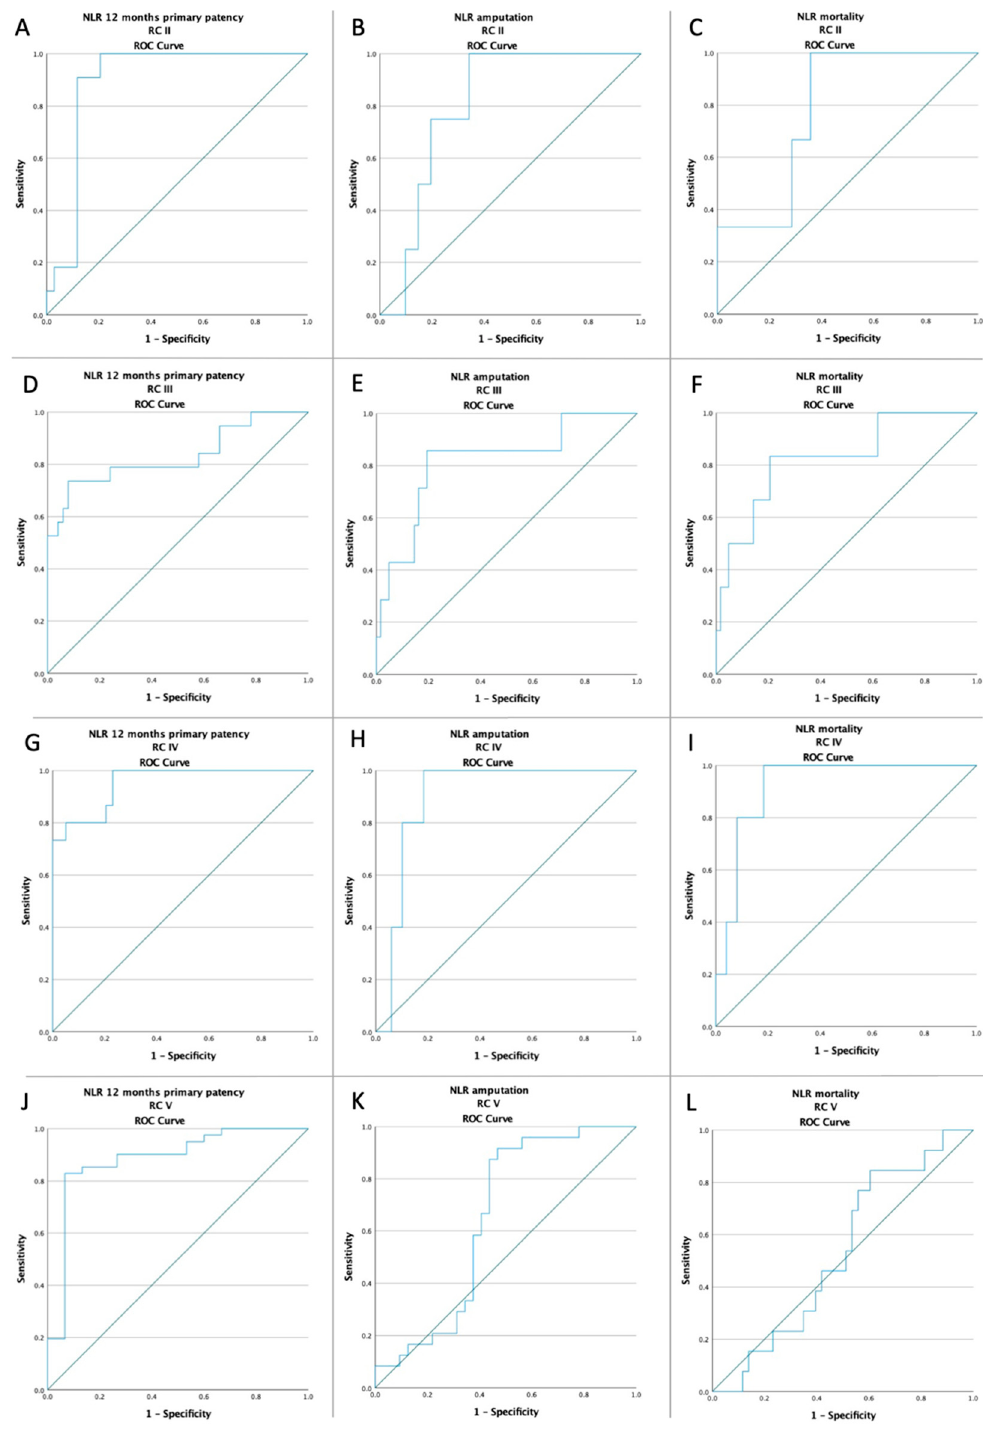
Figure 2. ROC curve analysis ( A ) for NLR with respect to 12 months primary patency in RC 2 patients (AUC: 0.893; p < 0.001), ( B ) for NLR with respect to amputation rate in RC 2 patients (AUC: 0.805; p = 0.046), ( C ) for NLR with respect to mortality rate in RC 2 patients (AUC: 0.786; p = 0.101), ( D ) for NLR with respect to 12 months primary patency in RC 3 patients (AUC: 0.833; p < 0.001), ( E ) for NLR with respect to amputation rate in RC 3 patients (AUC: 0.818; p = 0.006), ( F ) for NLR with respect to mortality rate in RC 3 patients (AUC: 0.828; p = 0.008), ( G ) for NLR with respect to 12 months primary patency in RC 4 patients (AUC: 0.952; p < 0.001), ( H ), for NLR with respect to amputation rate in RC 4 patients (AUC: 0.898; p = 0.004), ( I ) for NLR with respect to mortality rate in RC 4 patients (AUC: 0.922; p = 0.002), ( J ) for NLR with respect to 12 months primary patency in RC 5 patients (AUC: 0.885; p < 0.001), ( K ) for NLR with respect to amputation rate in RC 5 patients